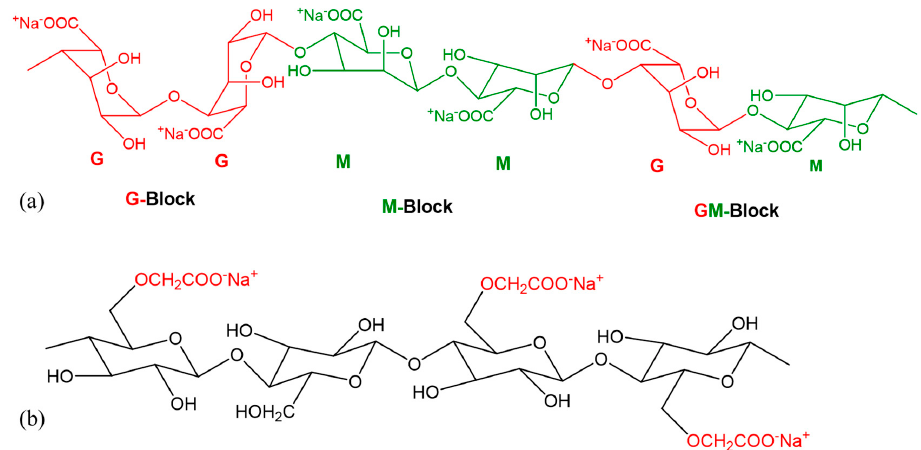
Figure 1. Chemical formula of ( a ) Alginate, ( b ) Carboxymethyl Cellulose (CMC).